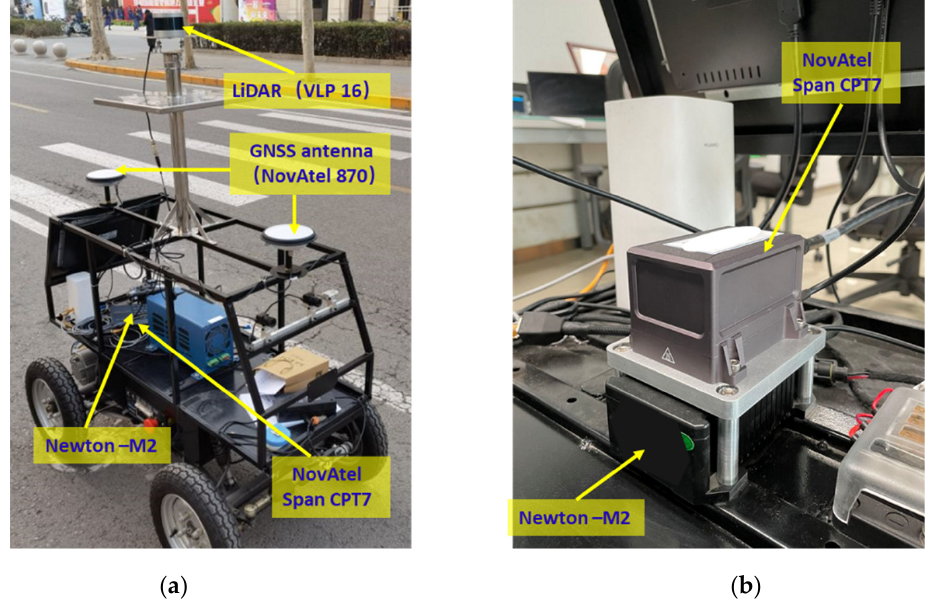
Figure 4. The experimental equipment for data collection. ( a ) The vehicle used for data collection and the installation positions of the sensors. ( b ) Local magnification of the Newton-M2 and NovAtel Span CPT7.